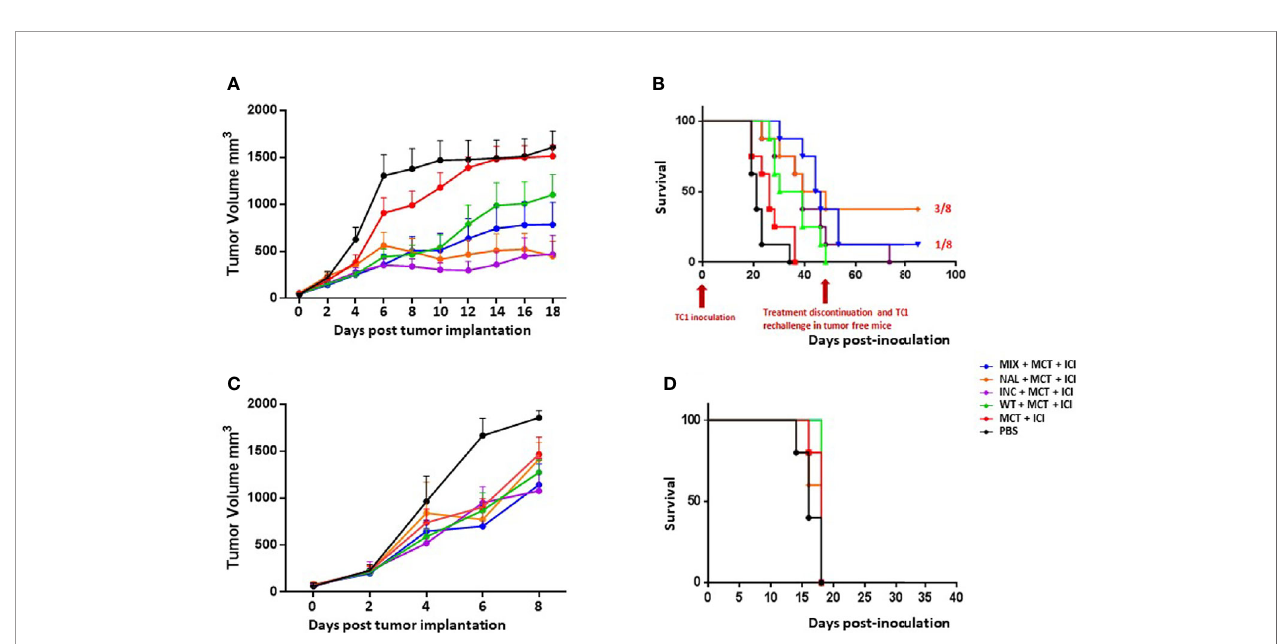
FIGURE 2 | Cancer vaccine ef fi cacy in therapeutic setting. C57BL/6 mice were administered with TC1 or B16F10 tumor cell lines. When palpable, indicated treatments were initiated. TC1 experimental model: (A) Tumor growth; (B) Keplein Mayer curve. B16F10 experimental model: (C) Tumor growth; (D) Keplein Mayer